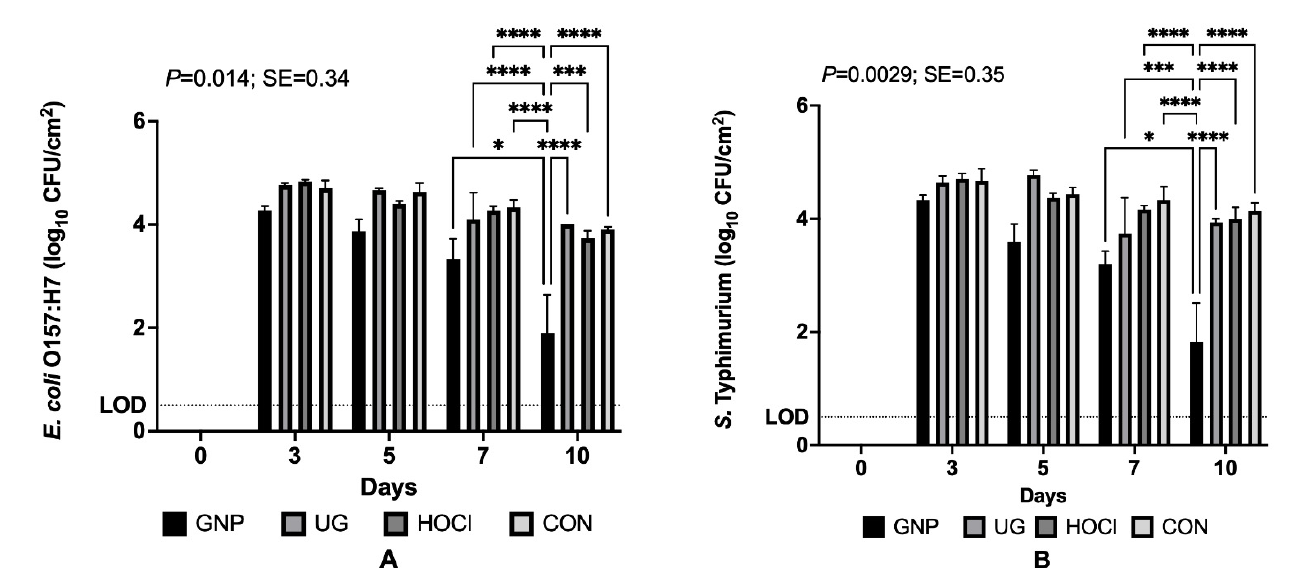
Figure 3. Least squares means of E. coli O157:H7 ( A ) and Salmonella typhimurium ( B ) on tomato skins from the interaction of sanitization treatment × number of days stored at 5 ° C. Bars represent means from triplicate identical replicates ( n = 3); error bars depict the standard error of means. SE = pooled standard error. Tomato samples were treated by sanitizer treatment, placed at 5 ° C for 3 days and then inoculated, and then returned to 5 ° C storage. GNP: 0.5 wt.% loaded polymeric nanoparticles;